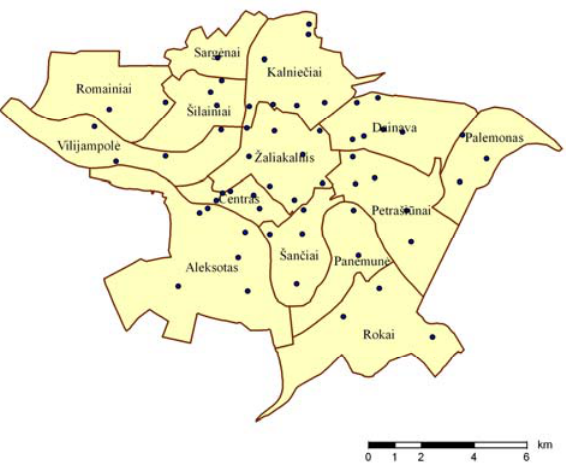
Fig. 1. Average nitrogen dioxide concentrationsin in various districts of Kaunas in 2008